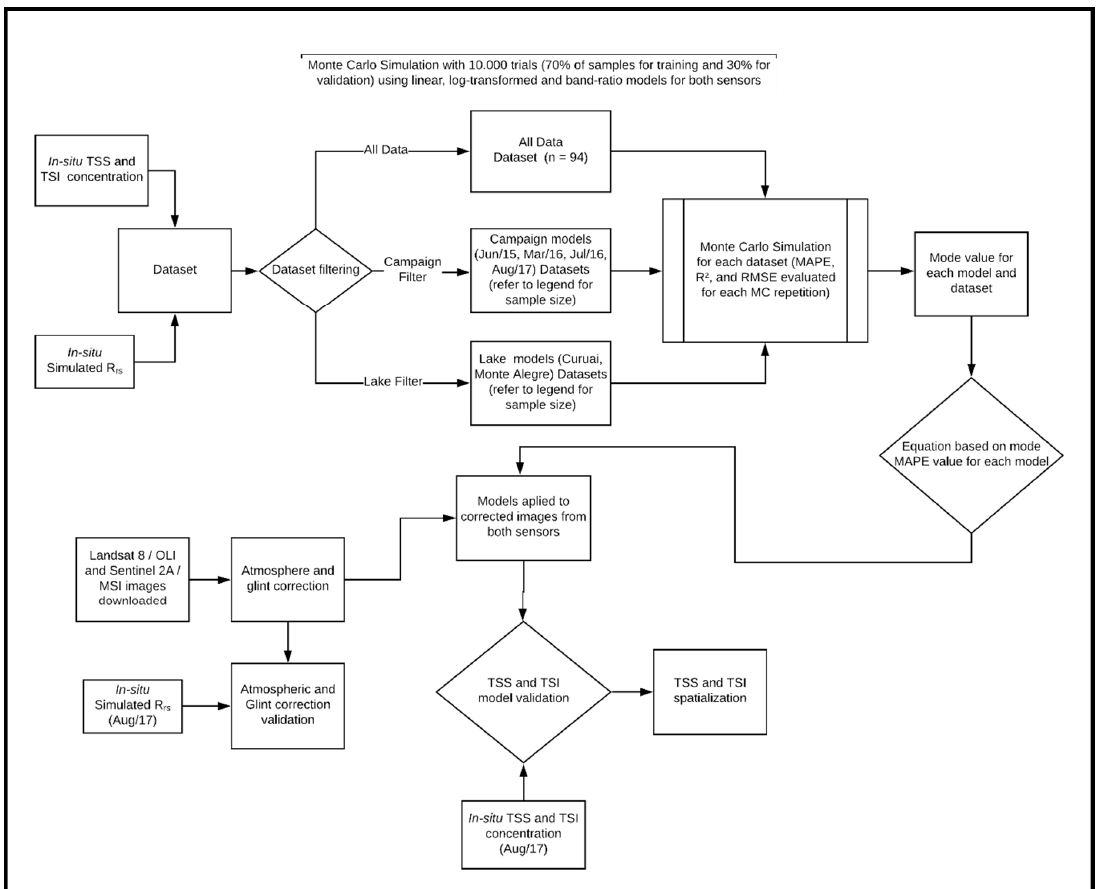
Figure 3. The methodology used for the calibration / validation of the Total Suspended Solids (TSS) and Total Suspended Inorganic Solids (TSI) empirical models and the application in the OLI and MSI scenes.